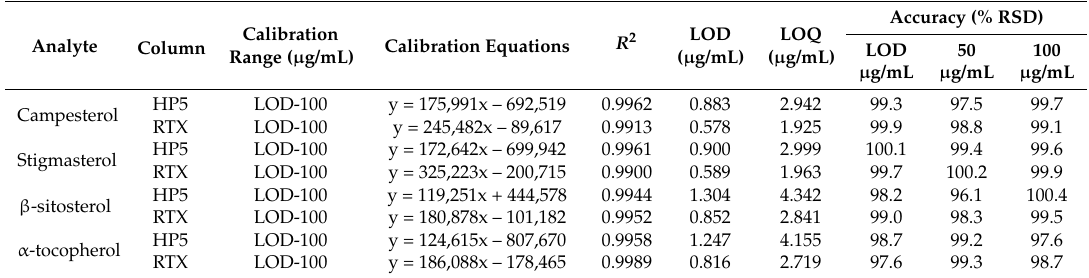
Table 1. Analytical parameters of the method proposed.